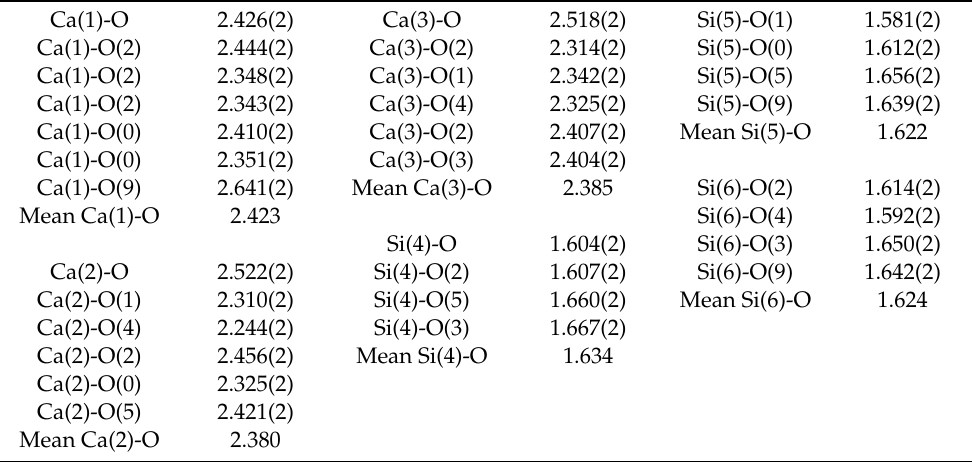
Table 10. Selected interatomic distances (Å) in wollastonite (CE